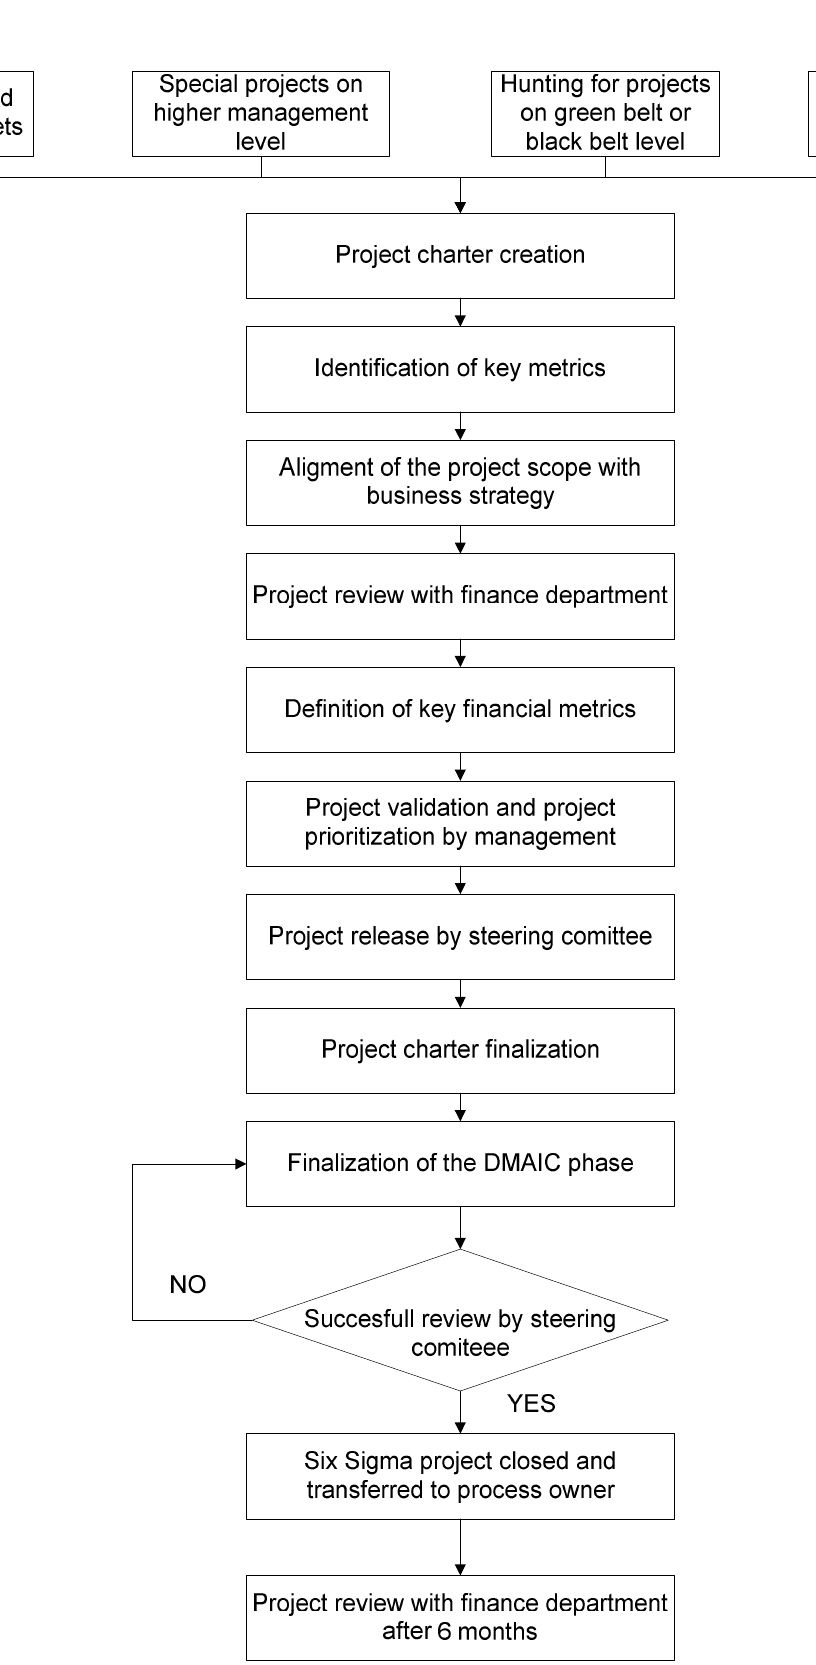
Figure 5 – Continuous evaluation of the six sigma project